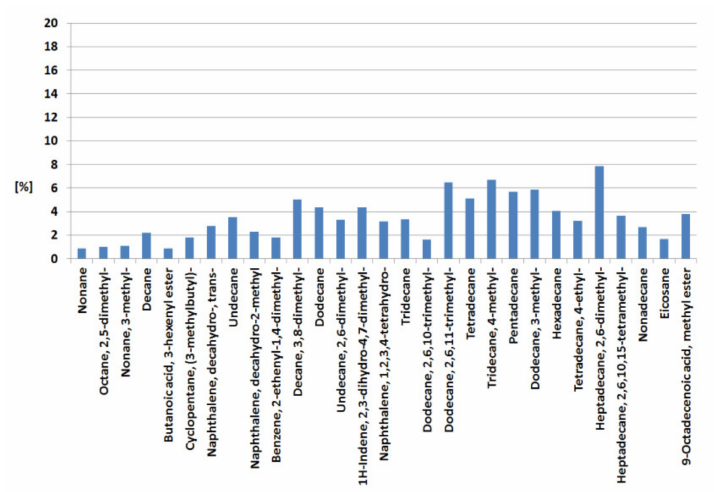
Figure 3. Chemical content of diesel with addition of 6% of methyl ester of yellow grease MEYG (rapeseed oil methyl